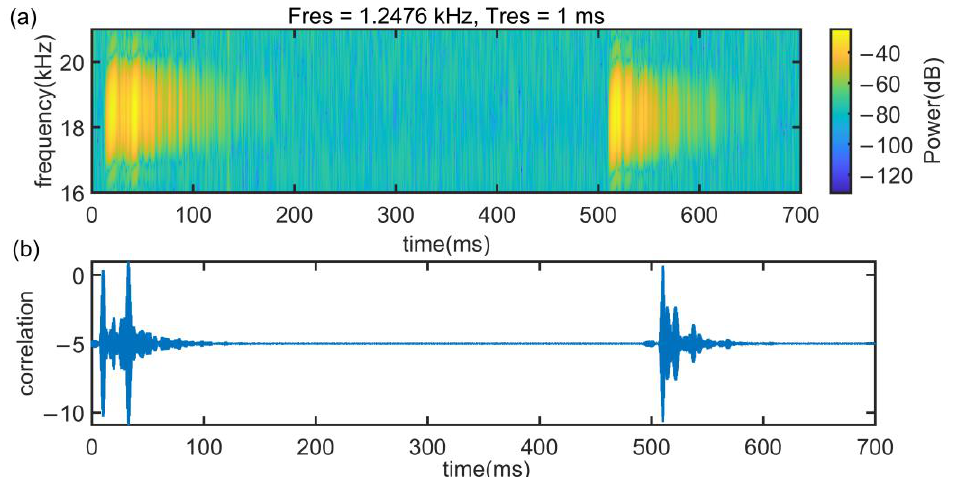
Figure 27. Signal propagation characteristics in case 3. ( a ) Signal Spectrum and ( b ) correlation results.